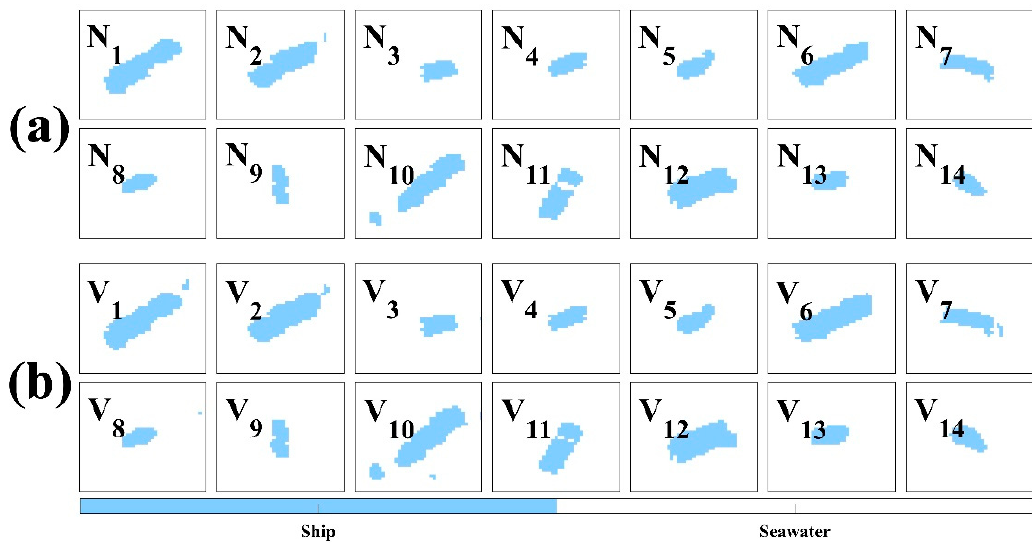
Figure 10. Spatial distribution of the classification result for the hyperspectral image based on the abundance fraction of the seawater endmember using ( a ) N-FINDR and ( b ) vertex component analysis (VCA) techniques.